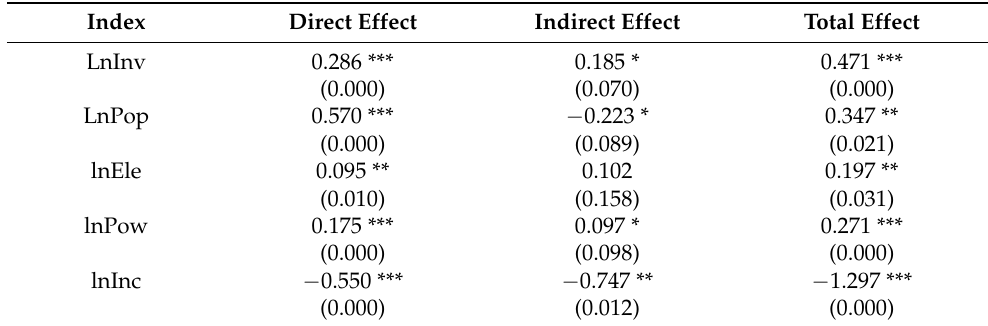
Table 11. Effect decomposition of time fixed